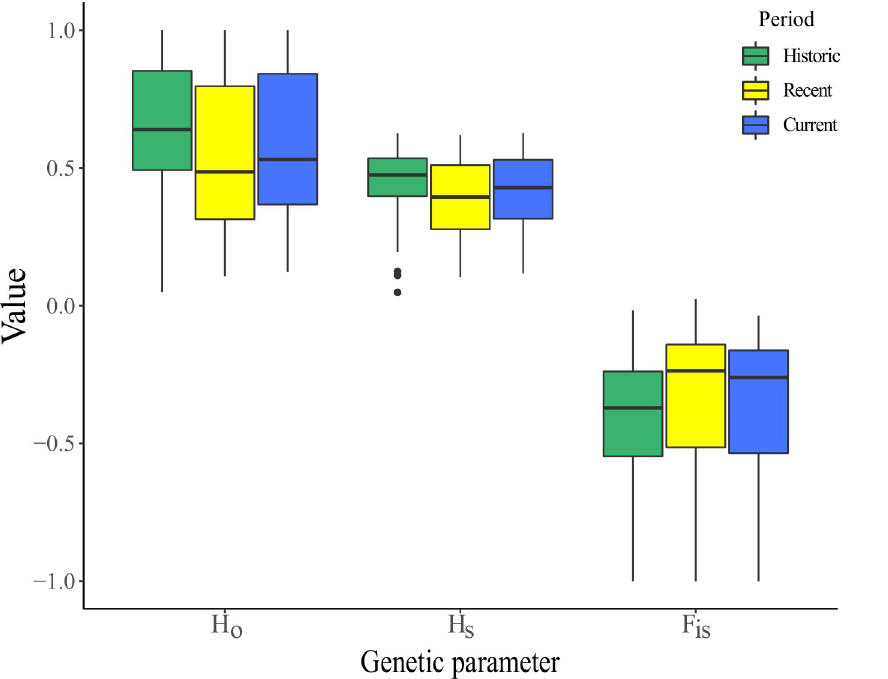
Fig 6. Temporal variation in heterozygosity (Ho & H E ) and inbreeding ( F IS ) in the regent honeyeater population.